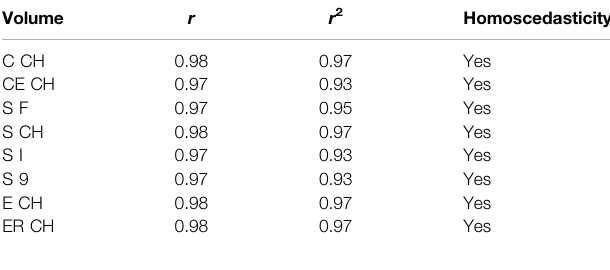
TABLE 4 | Correlation digital volumes vs circumferential measurement. Volume